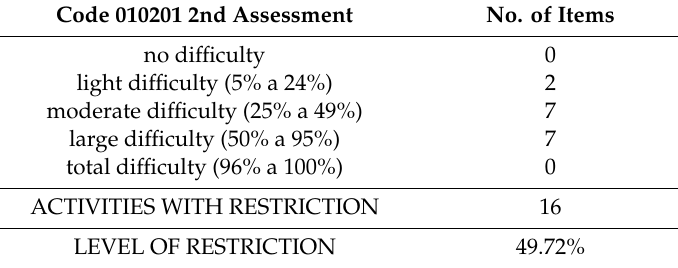
Table 7. Second evaluation data for child code 010201, 11 years